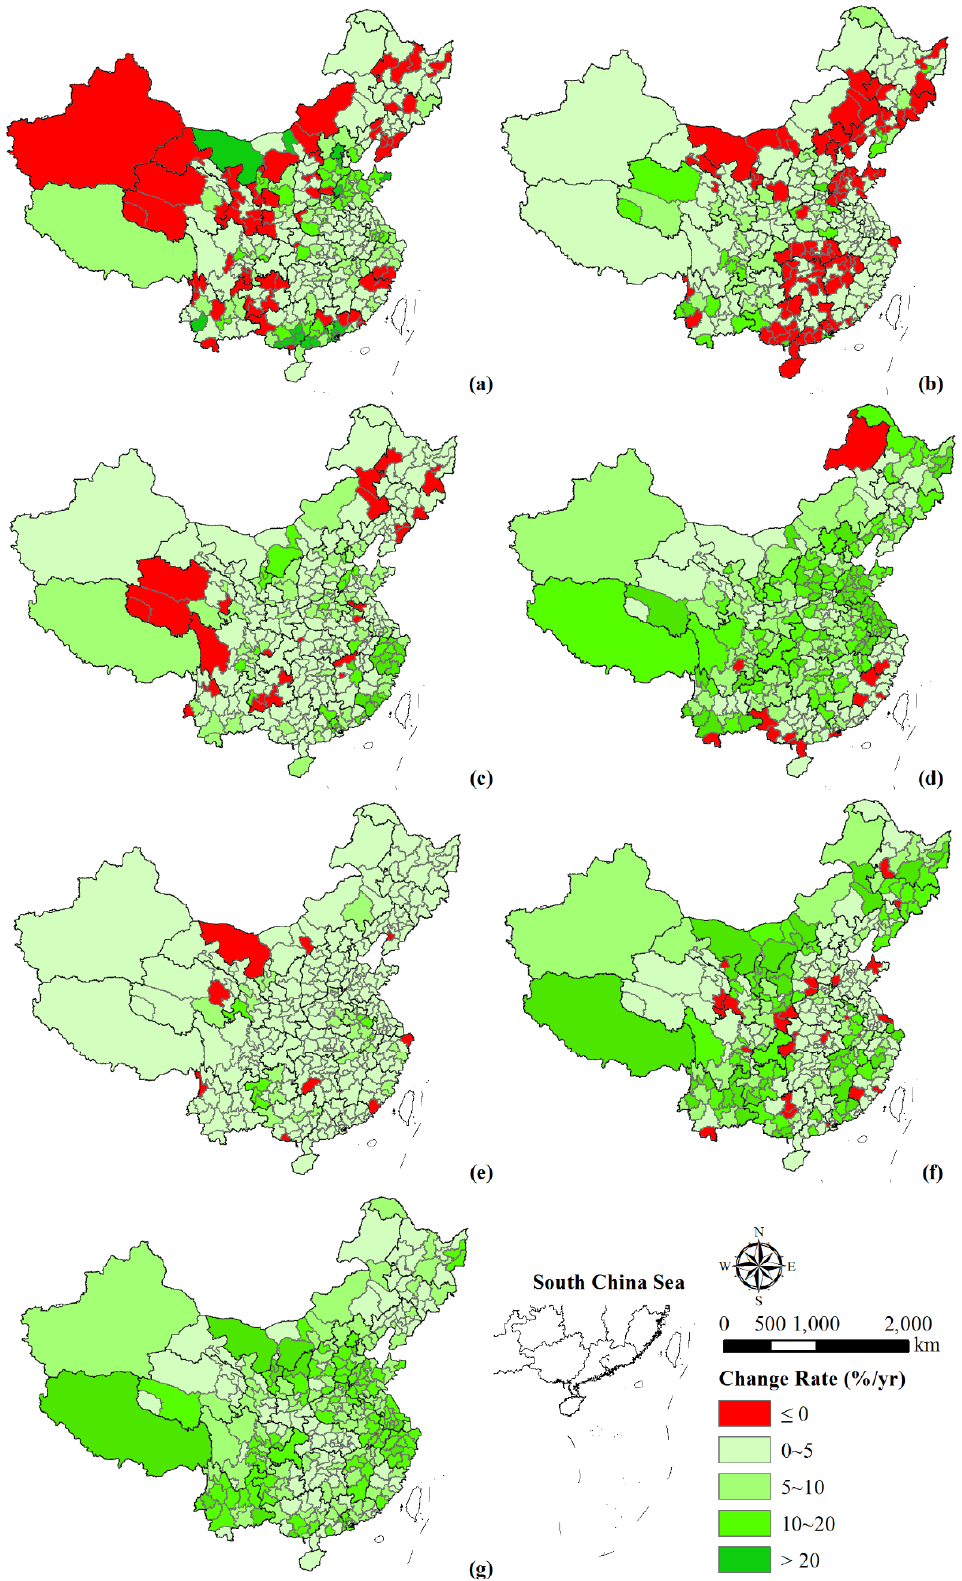
Figure 4. Spatial variation of the change rate of construction land during 1990–1995 ( a ), 1995–2000 ( b ), 2000–2005 ( c ), 2005–2010 ( d ), 2010–2015 ( e ), 2015–2018 ( f ), and 1990–2018 ( g ). Note: 0–5 is low–speed expansion, 5–10 is medium–speed expansion, 10–20 is rapid–speed expansion, and >20 is high–speed expansion.